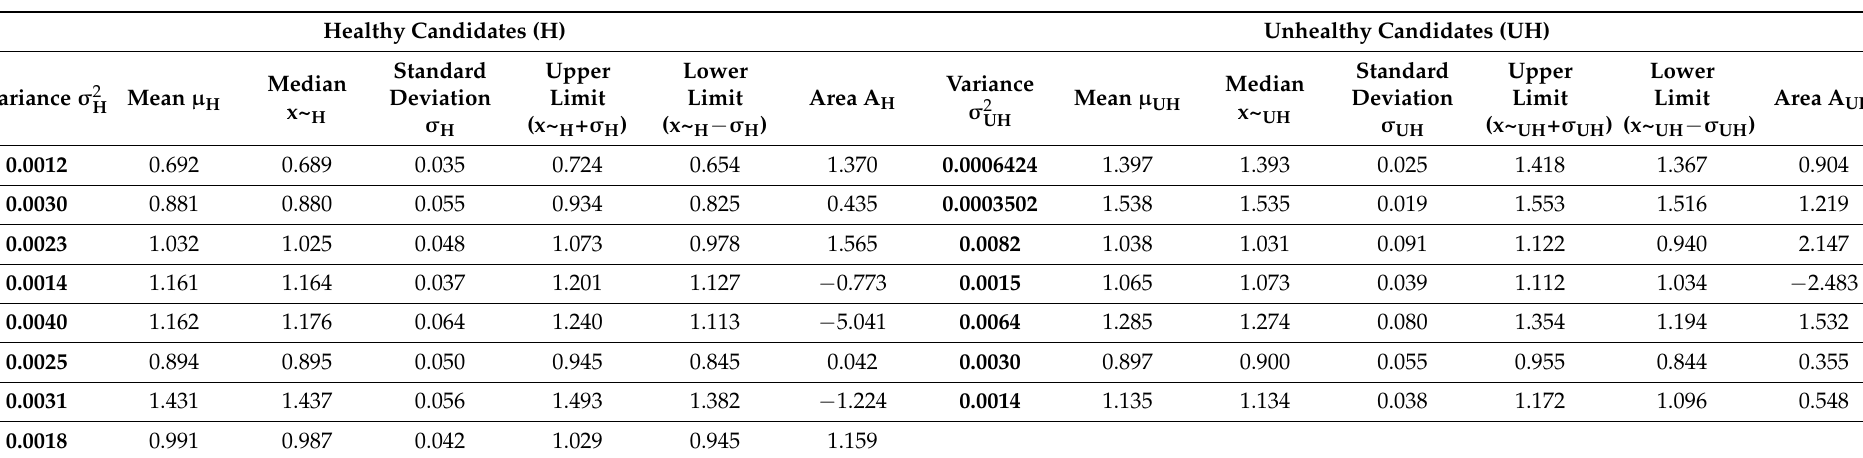
Table 6. Statistical computations for the cohort of healthy and unhealthy individuals for the combination of parameters JT interval, QRS interval, and RR interval. The variance, mean, median, and standard deviation values are